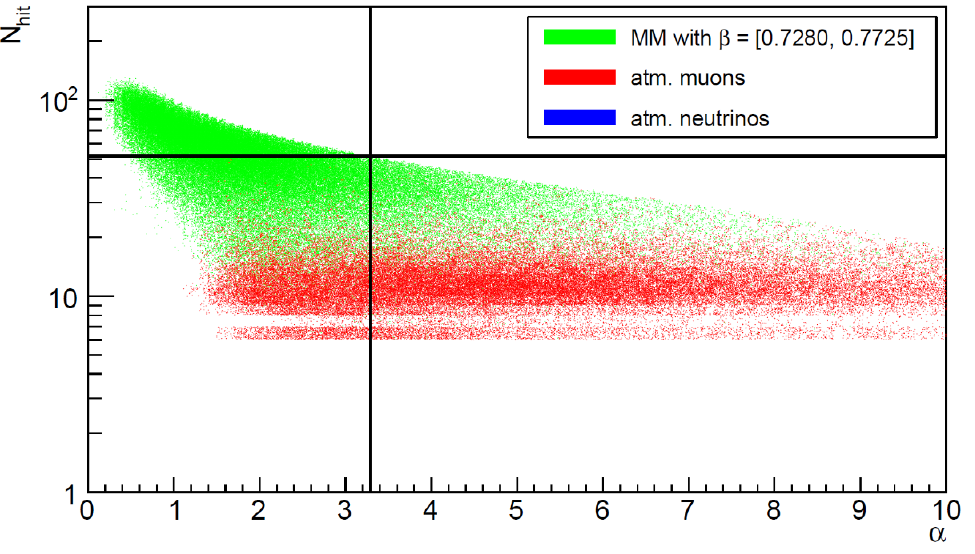
Figure 6 . Two-dimensional distribution of (cid:11) and N hit , for atmospheric muons, atmospheric neutri- nos, and MMs simulated in the velocity range [0 : 7280 ; 0 : 7725]. The cuts zenith (cid:20) 90 (cid:14) and t(cid:31) 2 (cid:20) b(cid:31) 2 have been applied, as well as the cut (cid:12) (cid:12)t = [0 : 7280 ; 0 : 7725]. The vertical and horizontal lines show the cuts applied after optimization. No neutrinos survived at this range of (cid:12) . The horizontal and vertical lines show the e(cid:11)ect of the cuts. The signal region corresponds to the left upper